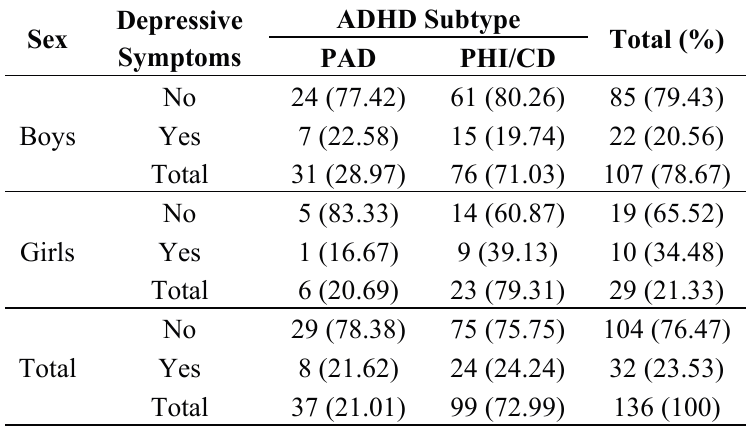
Table 2. Sample distribution of ADHD subtypes by presence of depressive symptoms and sex. The values are expressed as number and